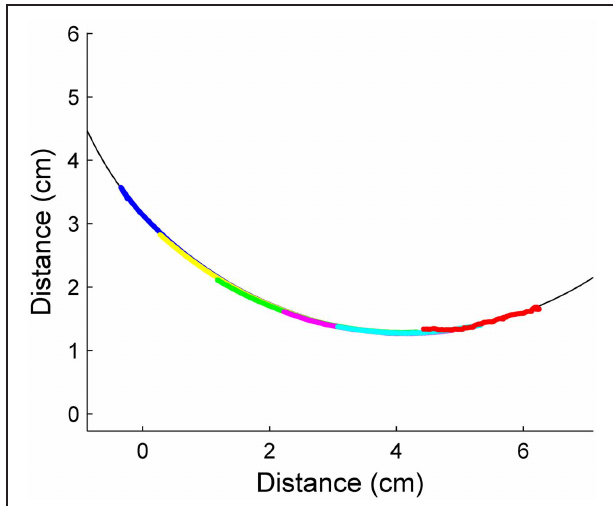
FIGURE 10 | Predicted radial distance using multiple whiskers. The predicted future contact points (red) line up very well with the actual surface of the cylinder (black line). Prediction error is 1.13 ± 1.2%. Each different color corresponds to contact points from separate